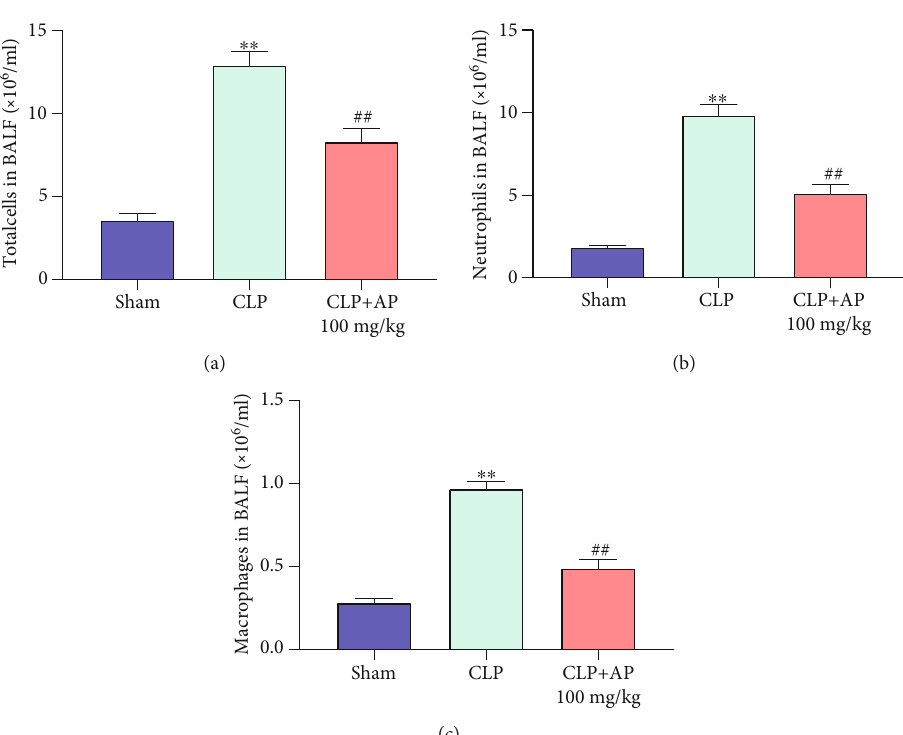
Figure 2: AP inhibited in fl ammatory cell in fi ltration in the BALF of sepsis-induced ALI mice. The number of total cells (a), neutrophils (b), and macrophages (c) was analyzed in BALF. ∗∗ P < 0 : 01 , vs. Sham group; ## P < 0 : 01 , vs. CLP